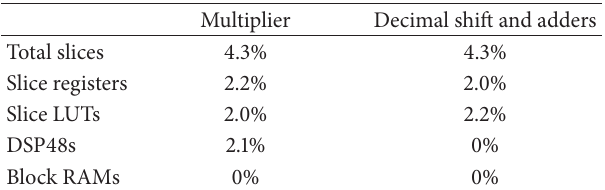
Figure 2: Implementation of the discrete integral in FPGA by the use of shift registers. Table 1: FPGA gate utilization for two different types of multiplica- tion.